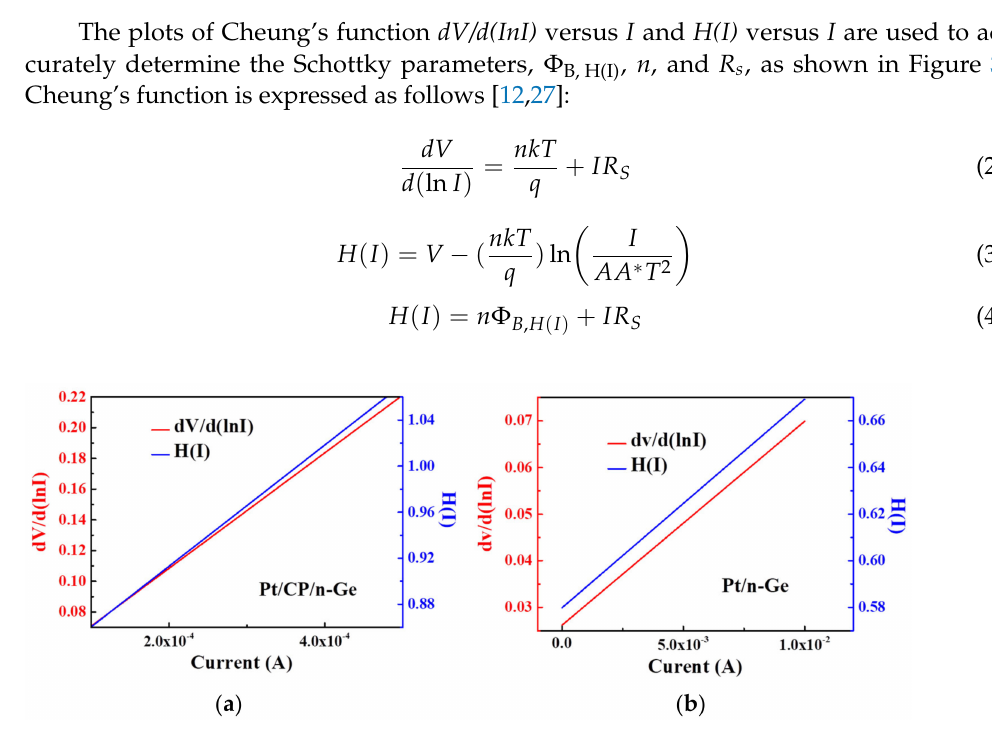
Figure 3. Plots of dV / d(InI) versus I and H(I) versus I using diode Equation (1) for Pt/n-Ge Schottky diodes ( a ) with and ( b ) without a CP